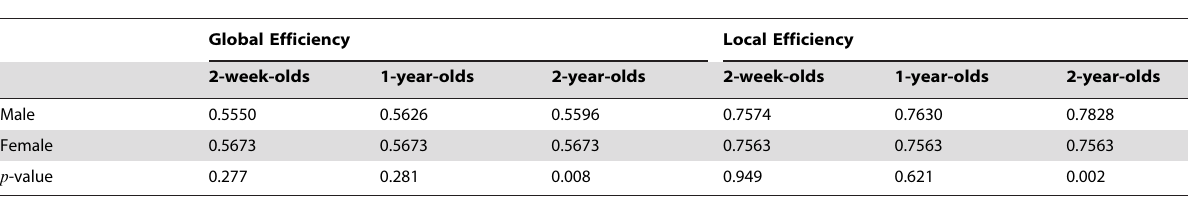
Table 4. Network Efficiency of the Male and Female